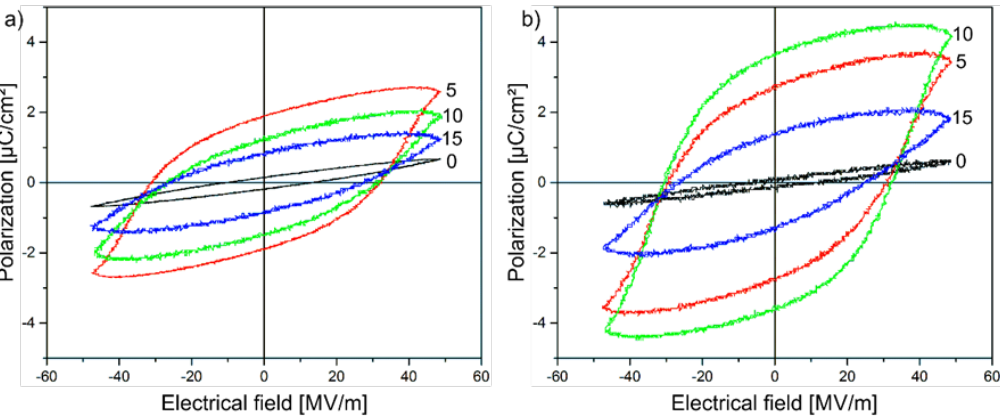
Figure 7. Hysteresis loops of the polarization of P(VDF-TrFE) composite films with different (Cd:Zn)S particle concentrations (0 = 0 vol %, 5 = 5 vol %, 10 = 10 vol %, 15 = 15 vol %) in dependence on the electric field E ( a ) under non-excitation and ( b ) under optical excitation conditions.